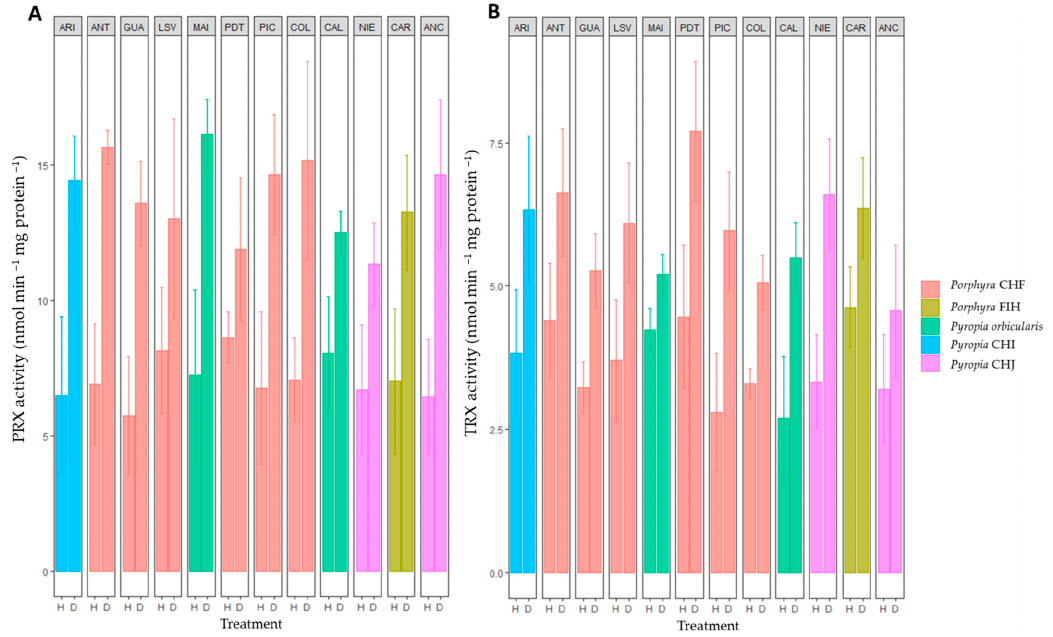
Figure 3. Specific activity of ( A ) PRX (peroxiredoxin) and ( B ) TRX (thioredoxin) during in situ hydration (H) and desiccation (D) stress in the Porphyra and Pyropia species evaluated in this study. Values are the mean ± SD of three replicates. ARI, Arica; ANT, Antofagasta; GUA, Guanaquerillos; LSV, Los Vilos; MAI, Maitencillo; PDT, Punta de Tralca; PIC, Pichilemu; COL, Coliumo; CAL, Calfuco; NIE, Niebla; CAR, Carelmapu; and ANC, Ancud (see Table 1 and Figure 6 for in-depth information). Similar to antioxidant enzymes, the LPX and carbonyl contents were remarkably high in the desiccated population compared with the hydrated one (Figure 4A). A two- way ANOVA revealed a significant effect of species and site on LPX concentration during both naturally hydrated and desiccated conditions (Table S3 part A). On the contrary, only the species influenced the carbonyl levels (Figure 4B and Table S3 part A). Notably, Pyro- pia CHI, Porphyra CHF, and Pyropia orbicularis populations from the northern–central zone (e.g., Arica, Antofagasta, and Maitencillo) exhibited high LPX levels compared with southern populations (Figure 4A). However, only Pyropia CHI from the northern most site (Arica) exhibited the highest carbonyl level (Figure 4B).